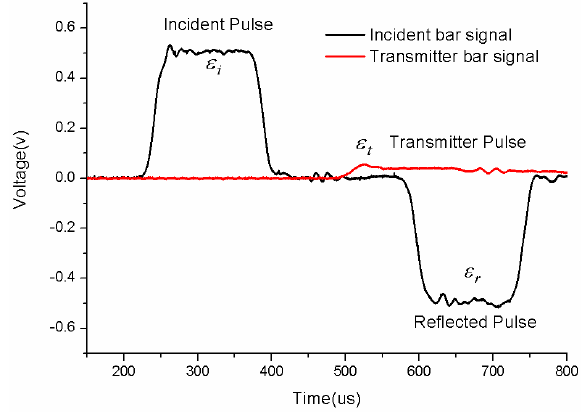
Figure 4. Typical signals measured from the gages on the bars.